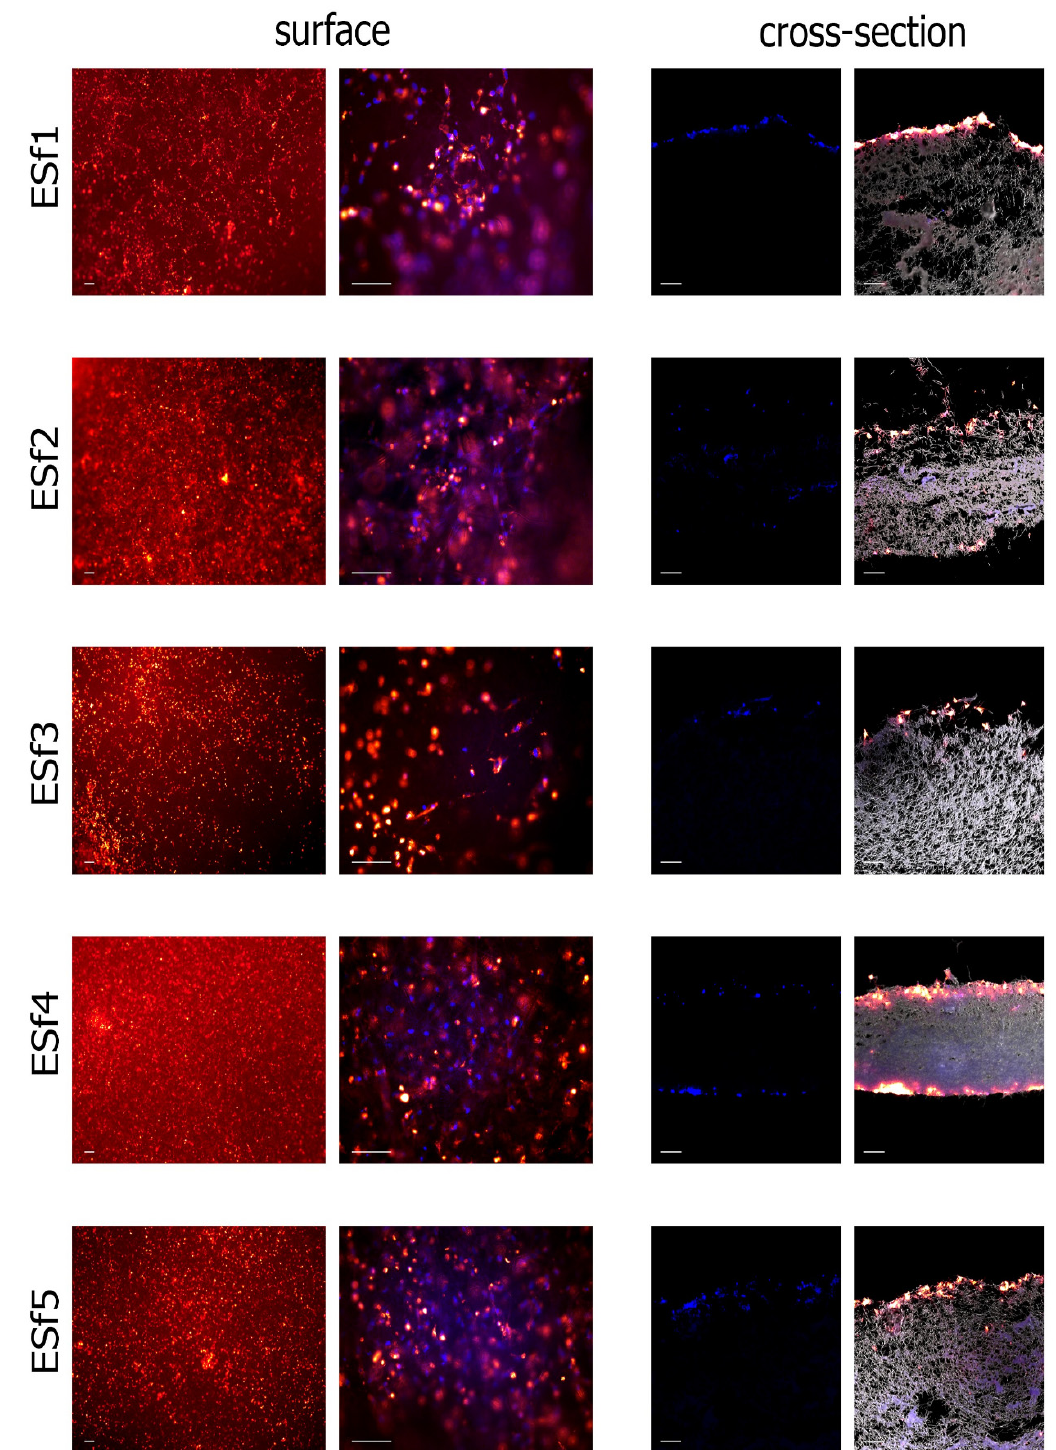
Figure 5. Cell–material interaction after 48 h seeding. MSCs are labeled with PKH26 fluorescent dye (orange), while cell nuclei are counterstained with Hoechst 33,342 (blue). Fluorescent microscopy of cells on the scaffold surface, combined dark field, and fluorescence microscopy of cells on cross sections; scale bar 100 μ m.